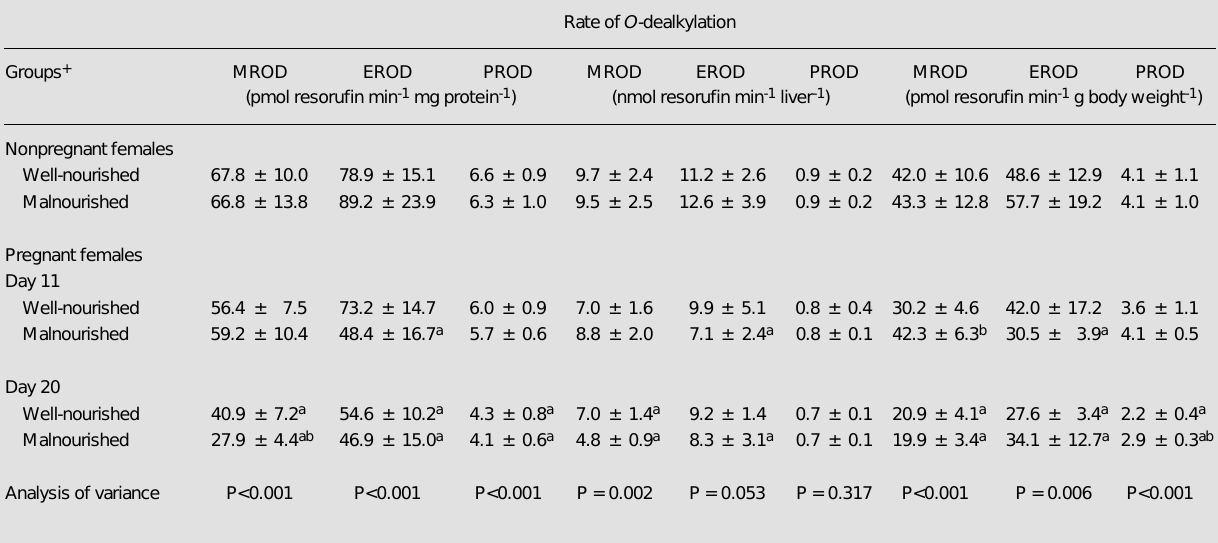
Table 2 - Ethoxy- (EROD), methoxy- (MROD) and pentoxy- (PROD) resorufin O -dealkylase activities in liver microsomes. Enzyme activity (amount of resorufin produced per minute) is reported per mg of microsomal protein, on a whole liver basis and per g of body weight. Data are reported as means ± SD. + Well-nourished rats were fed ad libitum . Malnourished rats received only 12 g of food per day from pregnancy day 0 on. Nonpregnant malnourished females were on a food restriction regimen for 20 days before sacrifice. Data were analyzed by one-way ANOVA followed by the Student t -test. a P £ 0.05 compared to the respective WN or MN nonpregnant group; b P £ 0.05 compared to the WN group on the same pregnancy day.